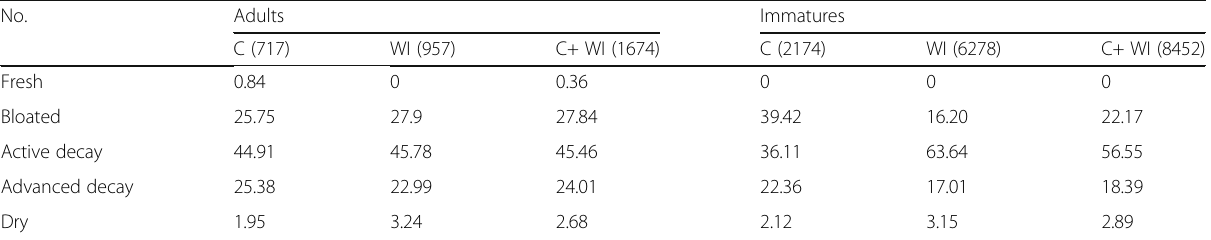
Table 3 Percentages (%) of collected of dipteran adults and immatures during different decomposition stages of rabbit carcasses No. Fresh